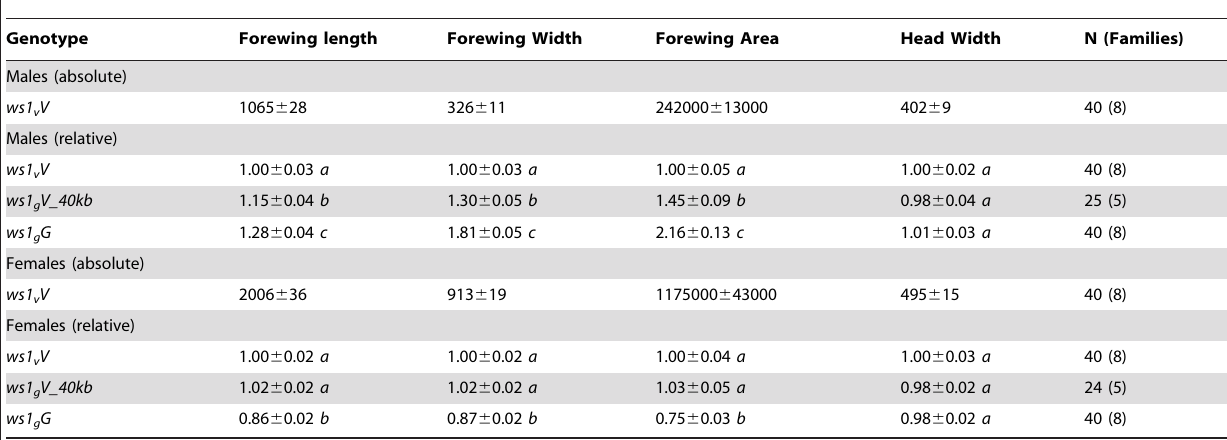
Table 1. Basic wing measurements of ws1 and wild-type